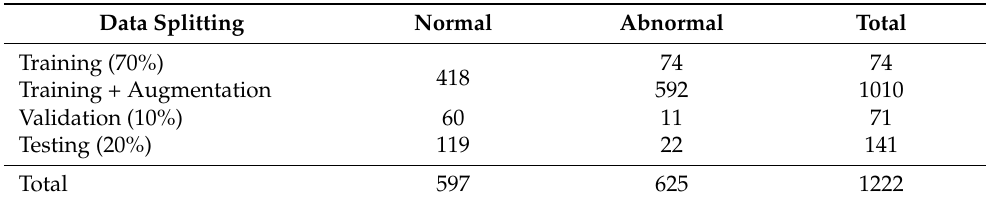
Table 2. INbreast data distribution of Approach A (binary classification) of each class. The number of augmented training breast images is listed in the second column of each class.